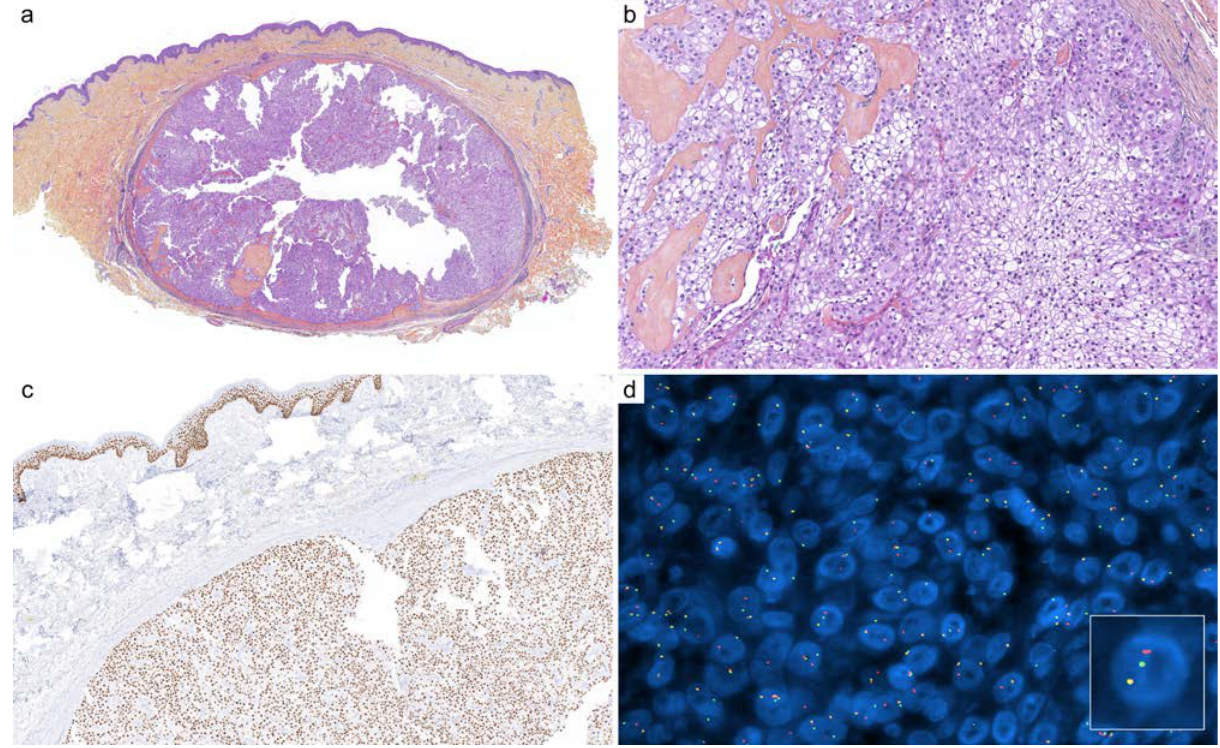
Figure 4. Cutaneous hidradenoma: ( a ) well-circumscribed nodular neoplasm (×25); ( b ) clear cell cytology and fibrous hyaline stroma (×200); ( c ) immunohistochemistry for p63 is usually intense and diffuse (×100); ( d ) fluorescence in situ hybridization (FISH, break-apart) demonstrates a clonal rearrangement of MAML2 (×1000).